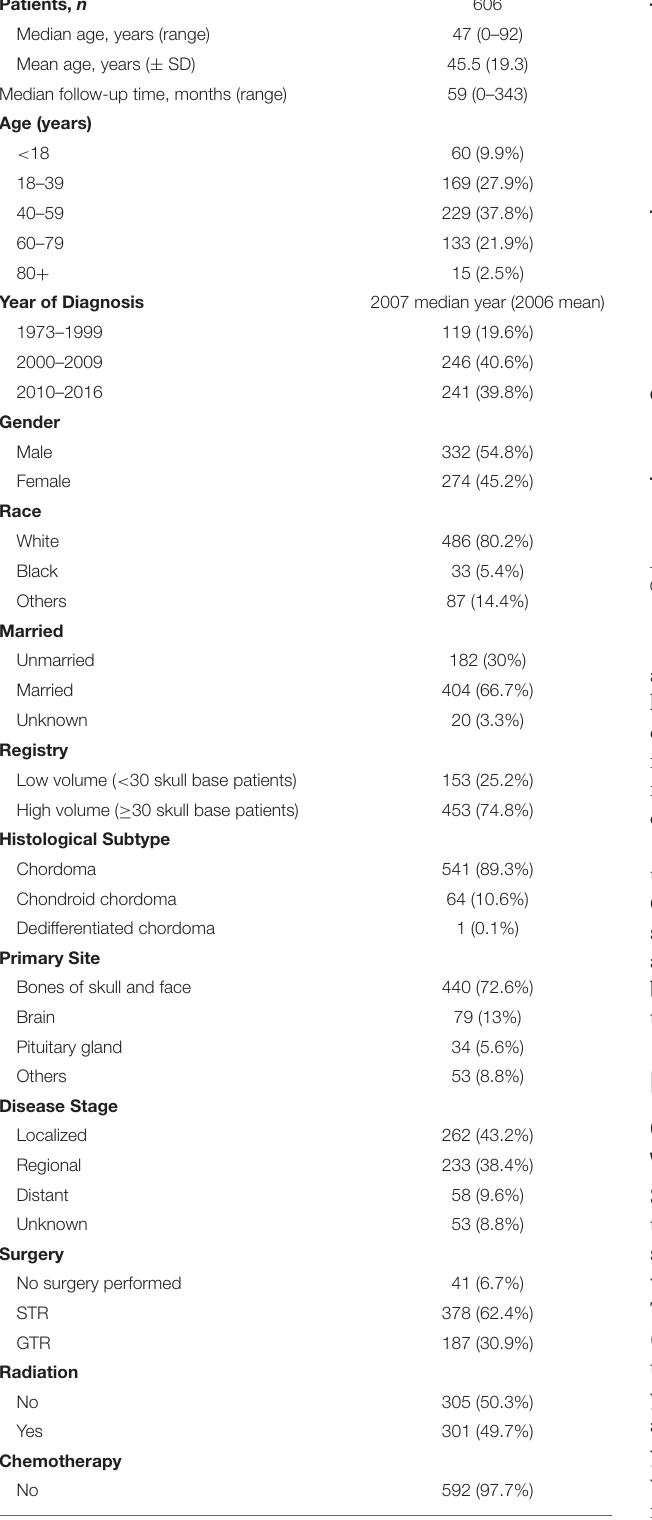
TABLE 1 | Characteristics of 606 patients with skull base chordoma tumors registered in SEER database (1973–2016). Patients,